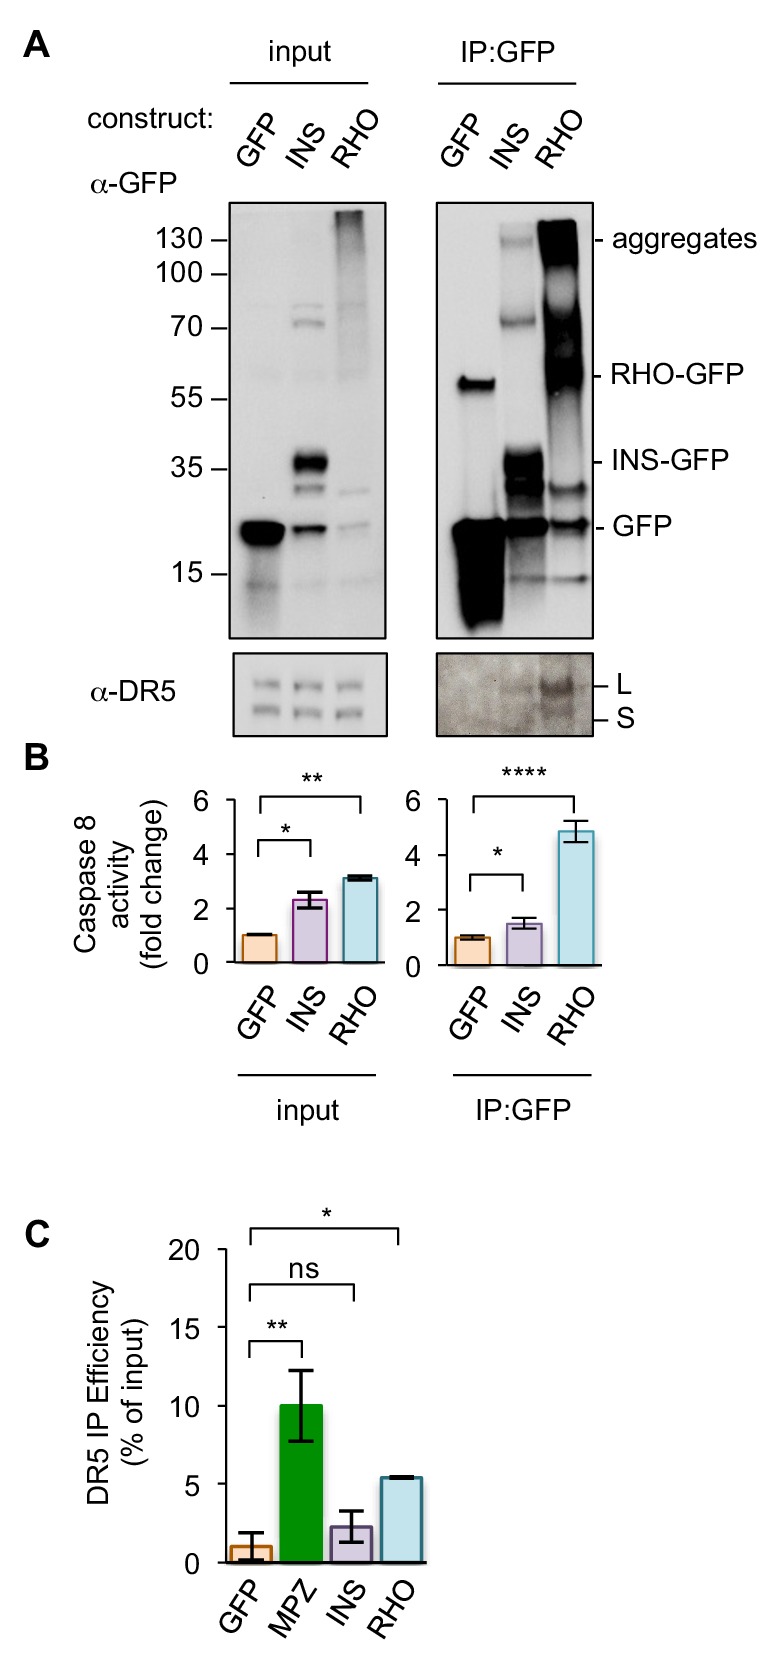
DR5 engages a selective subset of ER-trafficked client proteins upon prolonged ER stress.(A) Pulldown of GFP-tagged proteins from HCT116 transfected with INS, RHO, or cytosolic GFP. Inputs (left) and immunoprecipitated samples (right) were immunoblotted for GFP and DR5 (L and S indicate long and short isoforms, respectively). (B) Fold change in caspase 8 activity relative to cytosolic GFP for beads with immunoprecipitated contents described in Figure 1—figure supplement 5A as measured by caspase glo 8 luminescence (n = 2 biological replicates, error bars = SEM, * indicates p<0.05, ** indicates p=0.0013, **** indicates p<0.005 from unpaired t-tests with equal SD). (C) Quantification of the percent of total DR5 recovered in the IPs of GFP-tagged proteins, shown in Figure 1G and Figure 1—figure supplement 5A. (n = 3 biological replicates for GFP and MPZ, while n = 2 biological replicates for INS and RHO. * denotes p=0.016, ** denotes p=0.0035, and ns denotes p=0.39 from unpaired t-test with equal SD) The DR5 signal of the input and IP lanes were quantified from the same exposure and then normalized to the amount loaded on the gel. Source data of blots and quantification are provided in Figure 1—source data 2.